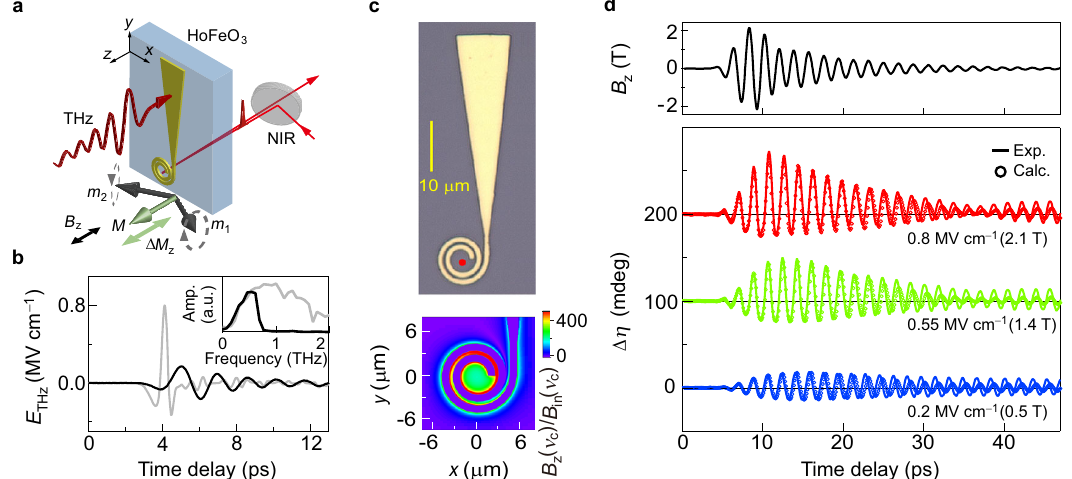
ν ν ν c =0.54THz, B z ( c )/ B in ( c ), is shown at the bottom, where B z is the magnetic enhancedbythemicrostructureand B in istheincidentTHzmagnetic fi eldstrength after the low-pass fi lter. d The black curve in the upper panel is the magnetic fi eld at the center of the spiral at the sample surface calculated by a fi nite-difference fi les of the time-domain simulation. The red, green, and blue curves show the observed time- domainsignalsofthechangeintheFaradayellipticityangle Δ η forTHzpulseswith E THz =0.8, 0.55, and 0.2MVcm − 1 , respectively. The red and green curves are offset for clarity. The open circles are the corresponding results calculated by using the LLG equation and considering the magneto-optical effect. Note that “ a.u. ” is the abbreviation for “ arbitrary units ”